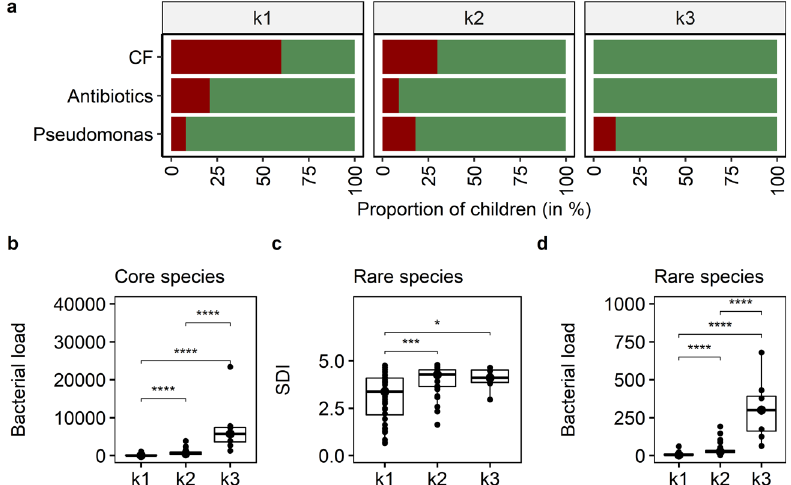
Fig. 4 Cluster characteristics based on clinical and microbial community data. a Proportion of children in each cluster who were diagnosed with CF (red), considered as P. aeruginosa -DNA positive (red), received antibiotics in the month of sampling (red) and those who did not (green). b Bacterial load of core species in terms of bacterial cells per human cell (Kruskal – Wallis p value < 0.0001, e2 = 0.60, CI = 0.45 – 0.72). c Shannon diversity indices (SDI) of rare species (Kruskal – Wallis p value = 0.0005, e2 = 0.17, CI = 0.05 – 0.34) and d bacterial load of rare species across the three cluster groups (Kruskal – Wallis p value < 0.0001, e2 = 0.55, CI = 0.39 – 0.69). Pairwise comparison was done using the Conover – Iman test and Benjamini – Hochberg adjustment (pairwise p values are given in the diagram with * p < 0.05, ** p < 0.01, *** p < 0.001, **** p < 0.0001). The centre line of the boxplot depicts the median (50th percentile). The lower and upper boundary of the box represent the fi rst (25th percentile) and third (75th percentile) quartile, and hence de fi ne the interquartile range (IQR). Whiskers extend from the box to the largest/smallest non-outlier data point (1.5 ×